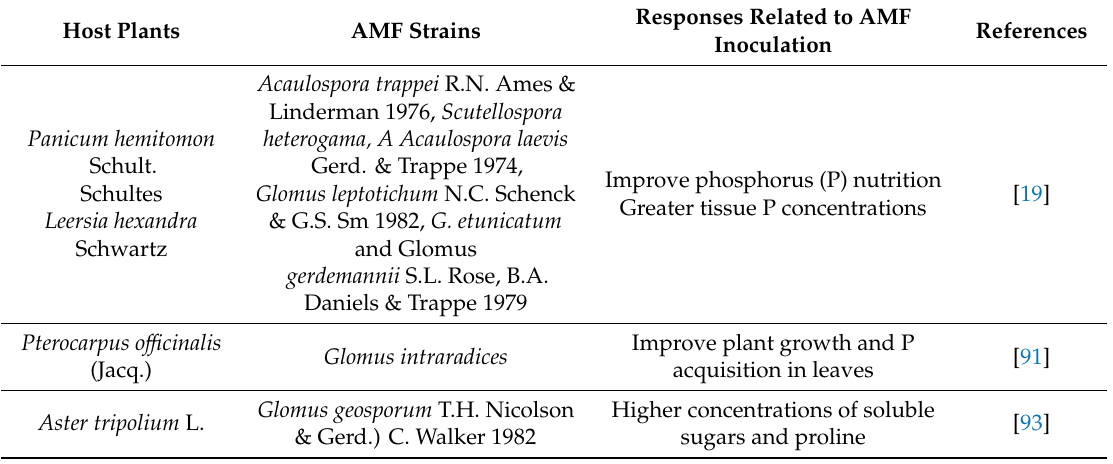
Table 2. Contribution of AMF in helping plants to cope with flooding